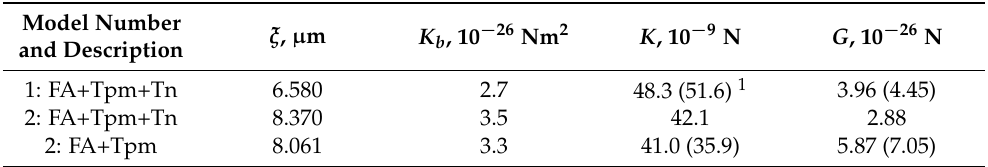
Table 2. The values of the persistence length, ξ , bending, K b , longitudinal, K , and torsional, G , stiffness estimated from MD